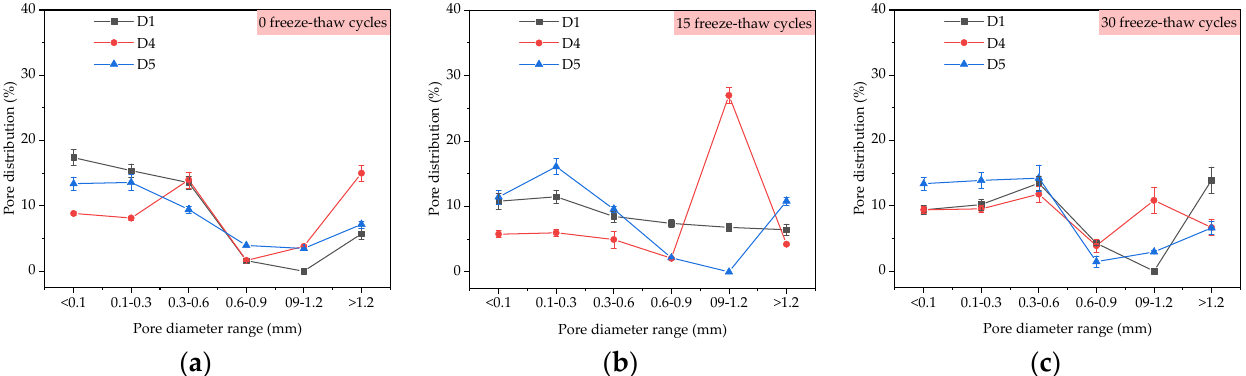
Figure 7. Pore distribution under the influence of redispersible emulsion powder: ( a ) 0 freeze-thaw cycles; ( b ) 15 freeze-thaw cycles; ( c ) 30 freeze-thaw cycles.